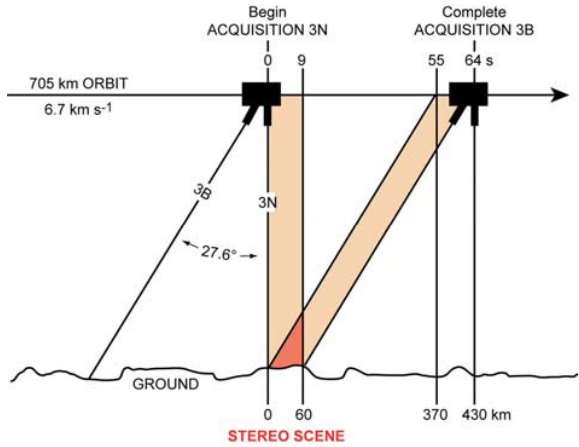
Fig. 1. Section of an ASTER nadir image (left) and an ASTER back-looking image (middle) acquired with 55s time difference over Lena river at the southern margin of reach Fig. 8e. Right panel shows velocity vectors tracked by correlating the nadir and back-looking images. Displacement vectors are slightly exaggerated. Vector grid spacing is 165m (11 ASTER pixels). Maximum ice-floe offsets are around 100m (6.7 pixels; 1.8ms − 1 ) . The reference grid in the left and middle panel is meant to facilitate visual detection of river ice movement over the 55s time lag.